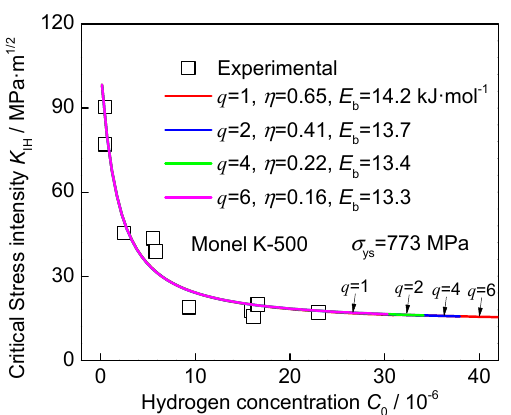
Figure 4. The fitting curves based on Equation (10) for critical stress intensity factor (CSIF) of Monel K-500 alloy using different 𝑞 values.